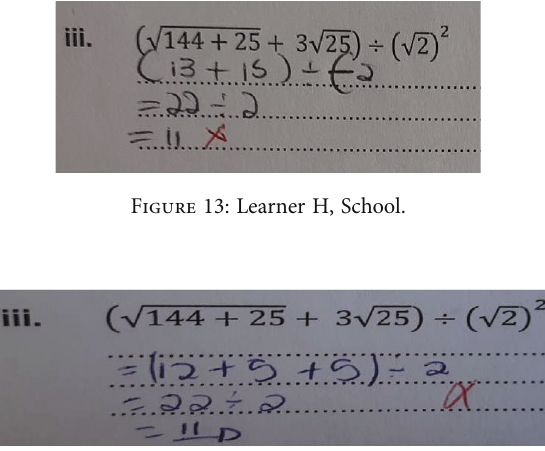
Figure 14: Learner AQ, School Y.